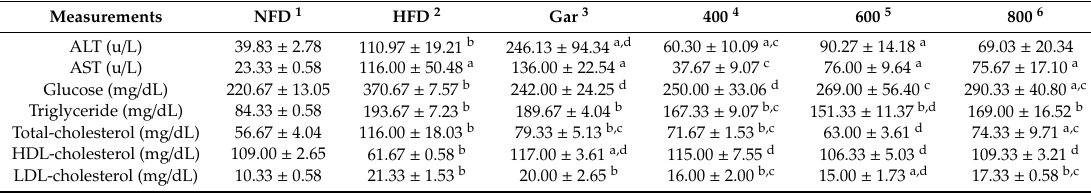
Table 4. Measurements of blood biochemical